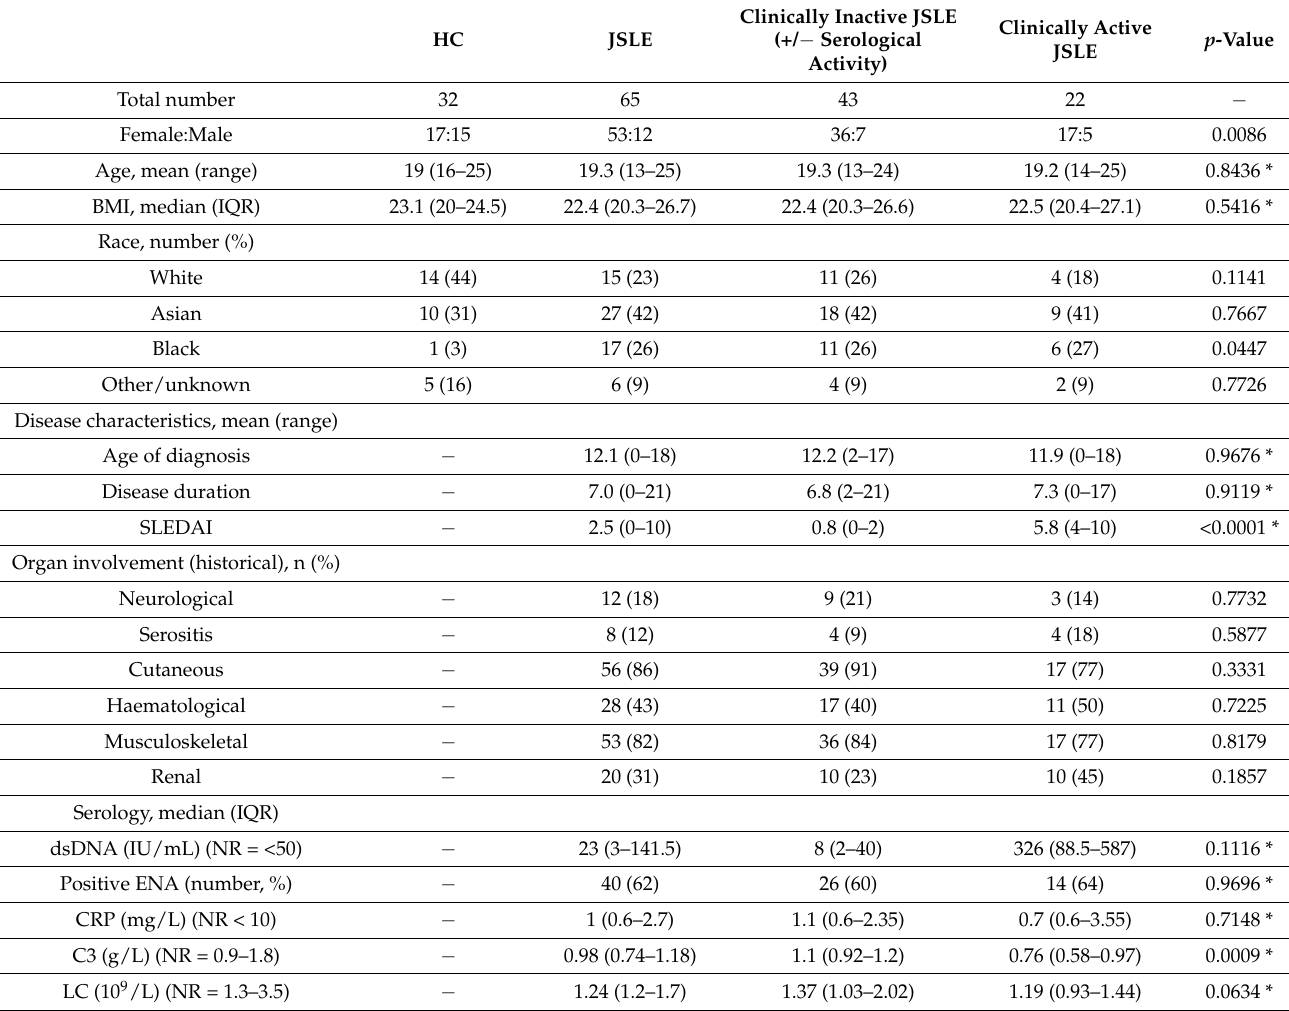
Table 1. Demographic and clinical table of all patients and healthy donors.